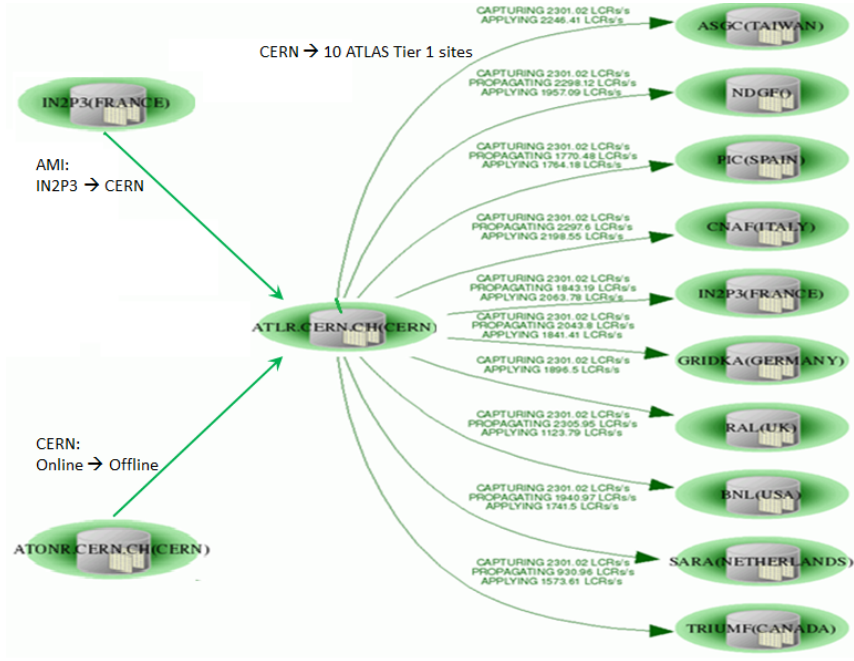
Figure 1. A snapshot of the ATLAS Database replication between Oracle RACs during 2008 (pre- Run 1). Arrows indicate the direction of Oracle Streams replication from source(s) to destination(s). The left side of the figure shows that data is consolidated in the central ATLAS Oracle o ffl ine database (ATLR) including data from the ATLAS online database (ATONR) as well as a replica of the AMI database from the IN2P3 site. Data in selected schemas in the central o ffl ine database are replicated to the 10 ATLAS Tier 1 sites. The Oracle Streams technology kept the data in sync within minutes of any changes on